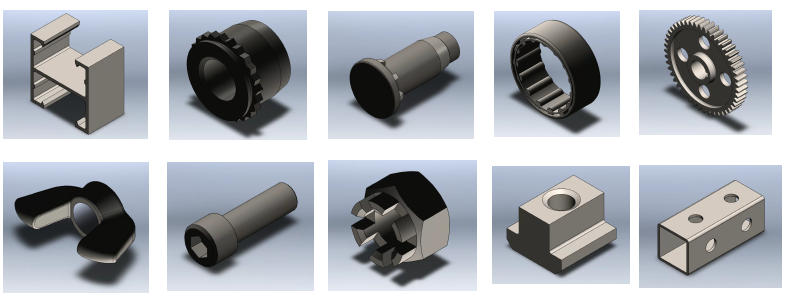
Figure 9. The set of items used for the normal operation and the abnormal condition tests.